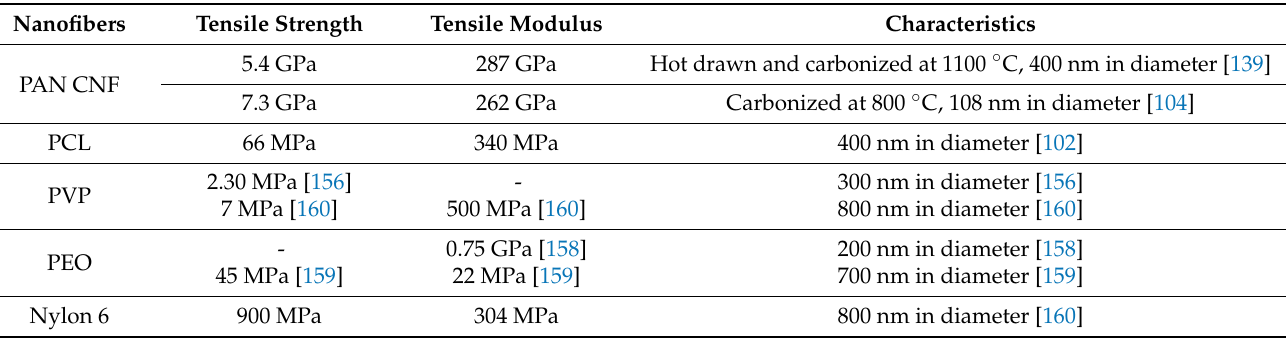
Table 2. Mechanical properties of